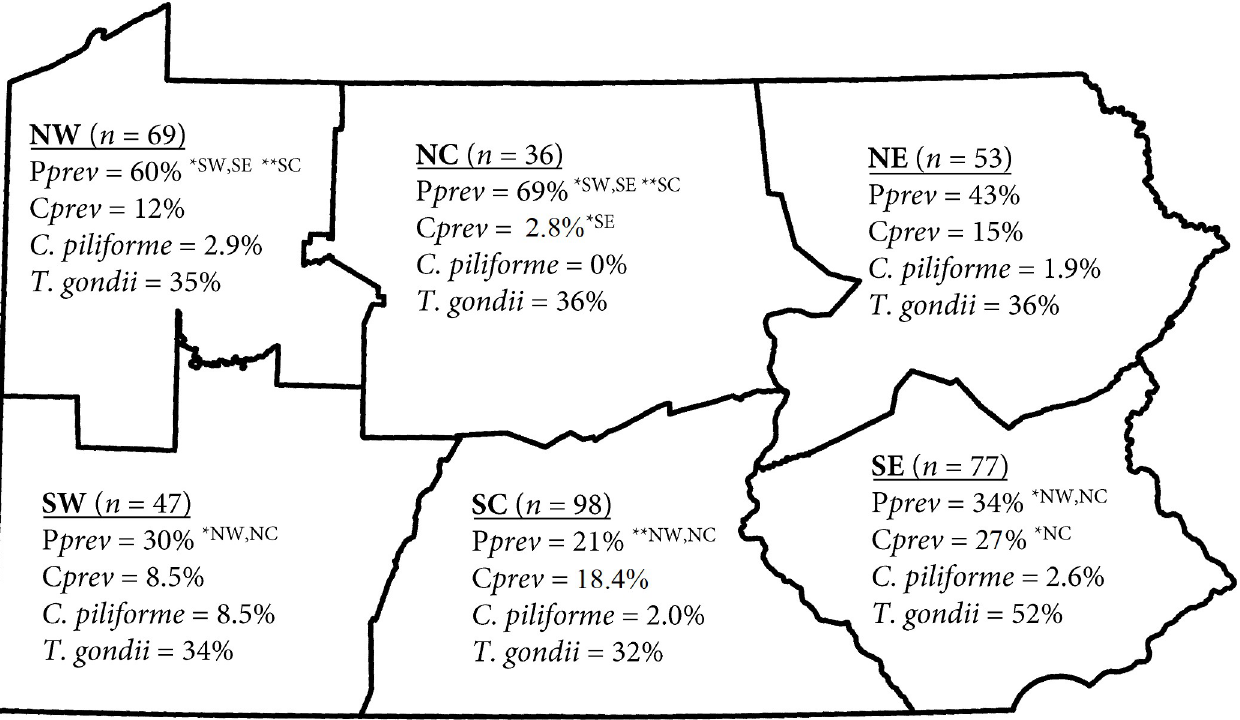
Fig 6. Prevalence of intestinal helminths (P prev ), cysts (C prev ), Clostridium piliforme , and Toxoplasma gondii in muskrats ( Ondatra zibethicus ) by region (NW-Northwest, SW-Southwest, NC-Northcentral, SC-Southcentral, NE-Northeast, SE-Southeast) in Pennsylvania, USA, 2018–2019. � = P < 0.001, �� = 0.001 < P < 0.05.